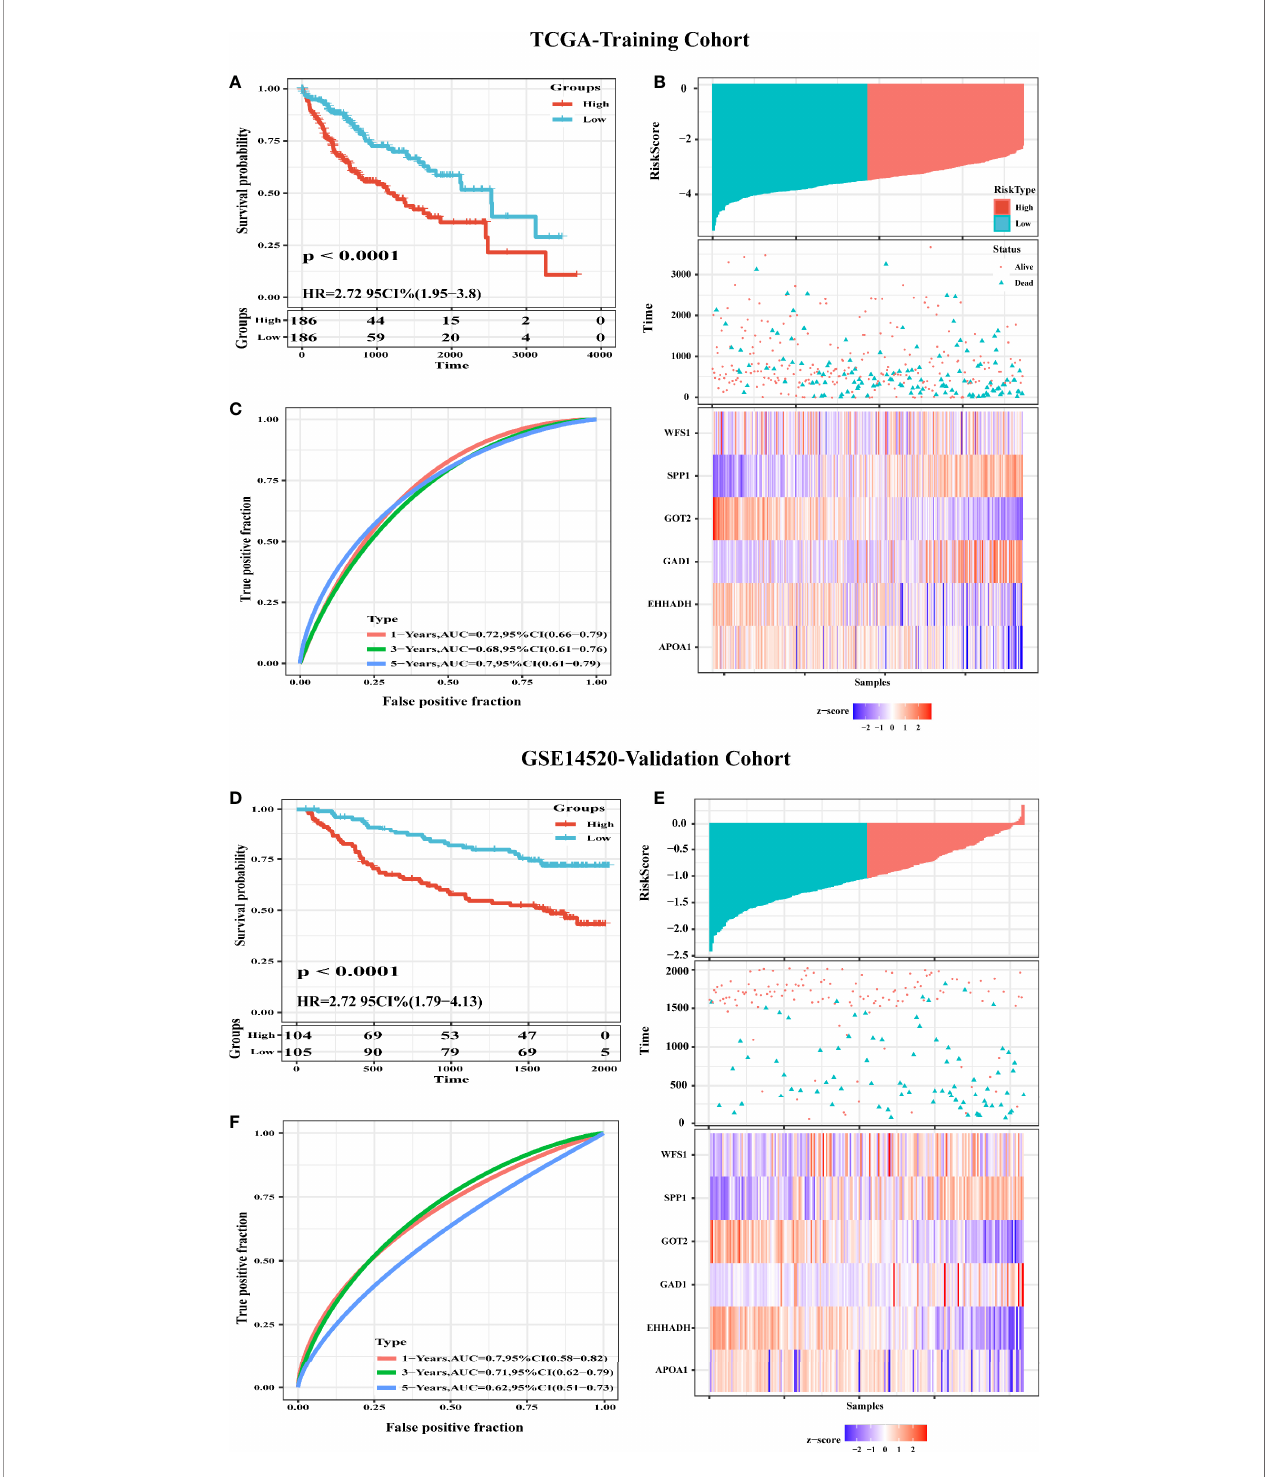
FIGURE 8 | Construction and Validation of a six-MRG prognostic risk signature. (A) Survival curves for the low risk and high risk groups of the six-MRG signature in TCGA cohort. (B) ROC curve analysis of risk scores for predicting OS. (C) TCGA-LIHC dataset focused on risk score, survival time, survival status, and expression of the six-MRG signature. (D) Survival curves for the low risk and high risk groups of the six-MRG signature in GSE14520 cohort. (E) ROC curve analysis of risk scores for predicting OS. (F) GSE14520 dataset focused on risk score, survival time, survival status, and expression of the six-MRG